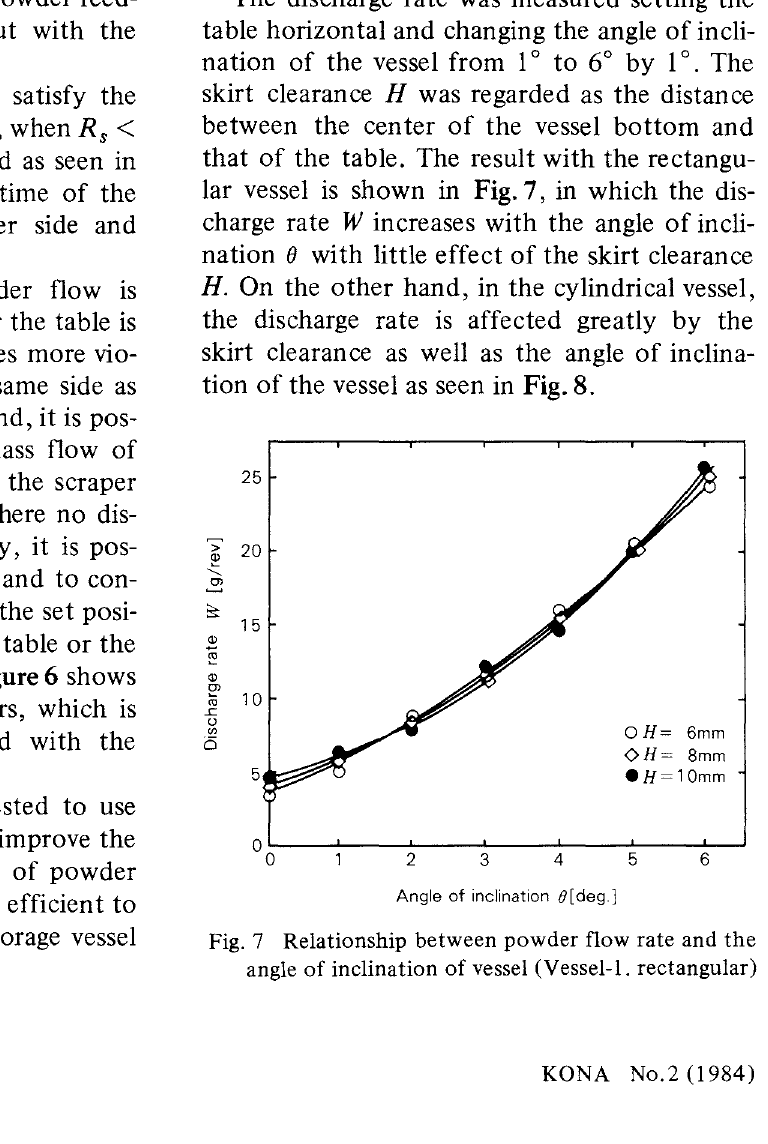
Fig. 7 Relationship between powder flow rate and the angle of inclination of vessel (Vessel-l.